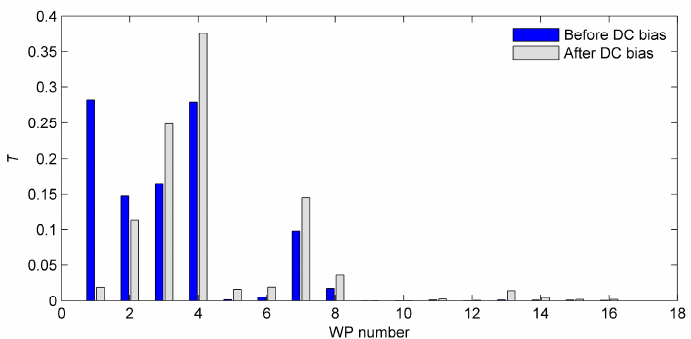
Figure 7. Feature T variation before and after DC bias.